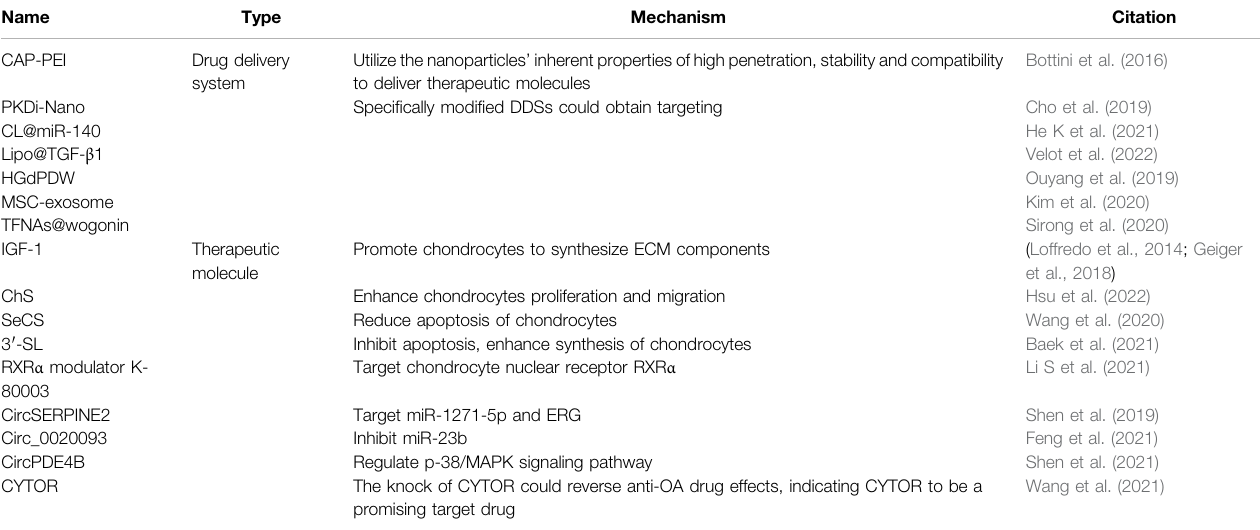
TABLE 1 | Chondrocyte targeted